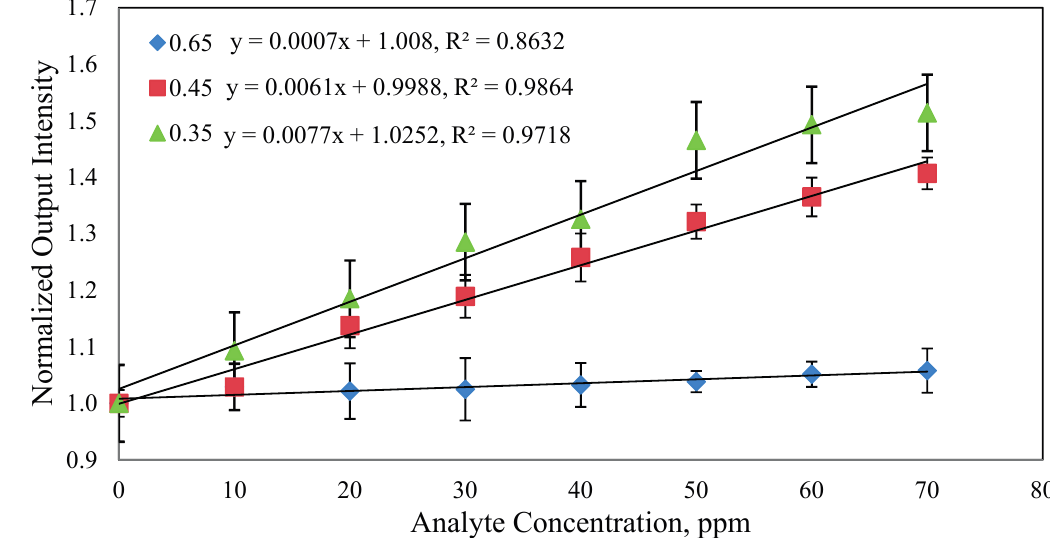
Figure 4. The variation of the normalized output intensity with tapered fiber diameters d = 0.65 mm, d = 0.45 mm and d = 0.35 mm for RBB at various